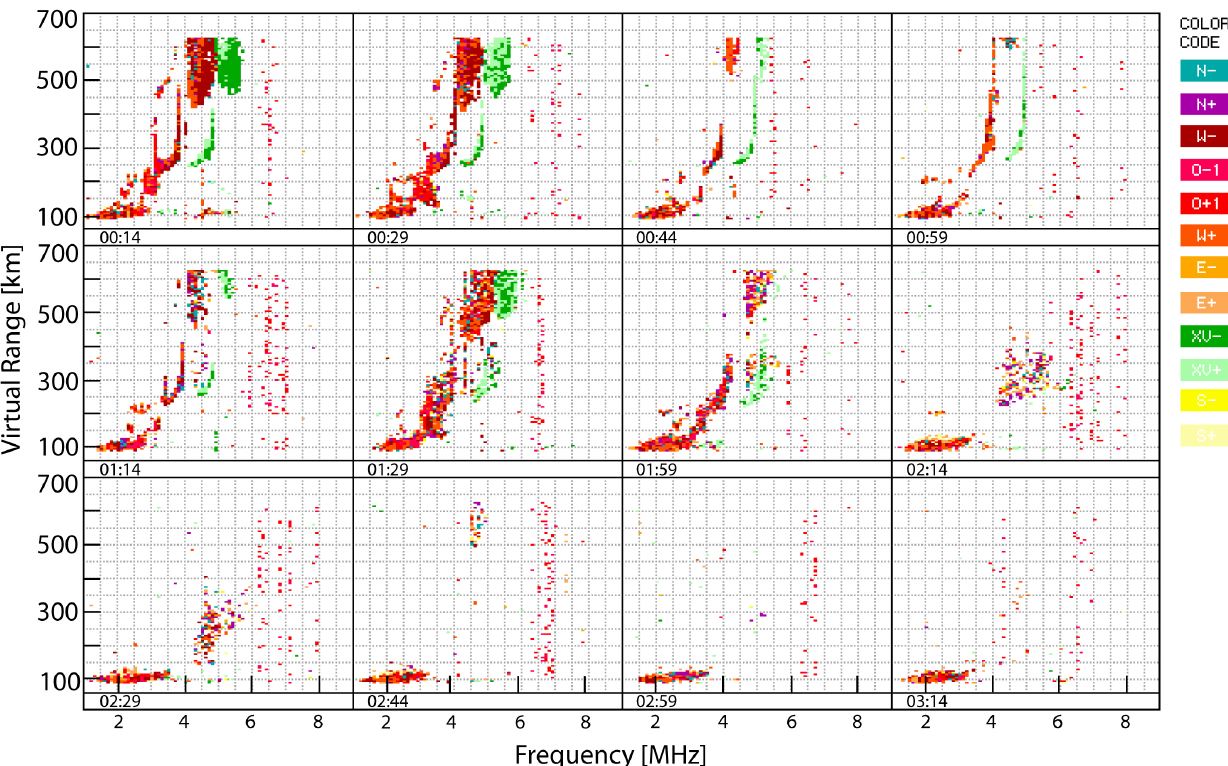
Fig. 3. Multi-beam ionogram records showing the development of a polar cap lacuna condition starting at 01:59 UT and lasting over 4h on 16 December 1996. Each ionogram ranges from 1 to 8MHz in 100kHz steps. Color-coded and optically weighted fonts provide coarse angle-of-arrival and Doppler information. All cardinal directions are given in a compass-oriented coordinate system. At each sounding frequency, a coherent integration of 64 phase-coded pulses at 200Hz PRF for multiplexed O- and X-modes is performed separately on the system four receiver antennas. The coarse frequency and height grid-lines are separated by 0.5MHz and 50km, starting from 1MHz and 60km,